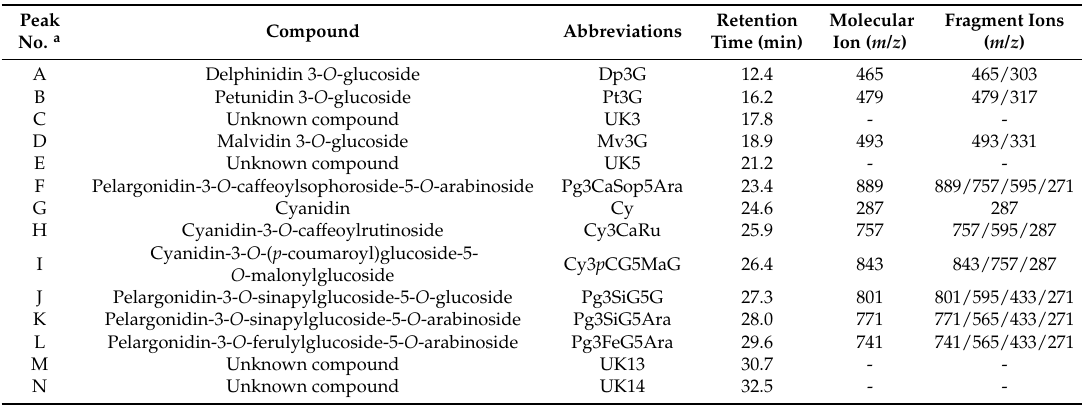
Figure 1. HPLC chromatogram of anthocyanin profiles in eight grape hyacinth cultivars. ( a ) Schematic diagram of retention time of anthocyanins in grape hyacinth tepals. Refer to Table 1; ( b ) Eight grape hyacinth cultivars from left to right: M. armeniacum , M. armeniacum ‘Dark Eyes’, M. aucheri ‘Mount Hood’, M. aucheri ‘Ocean Magic’, M. latifolium , M. azureum , M. ‘Pink Surprise’, M. aucheri ‘White beauty’. Table 1. Identification of anthocyanins in eight grape hyacinth cultivars.